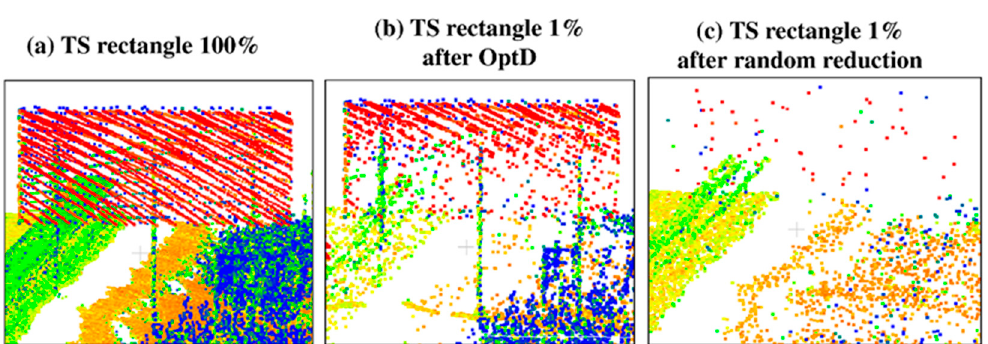
Figure 9. Data reduction effect on a triangular TS: ( a ) original, ( b ) triangular TS after OptD method, ( c ) triangular TS after random reduction.